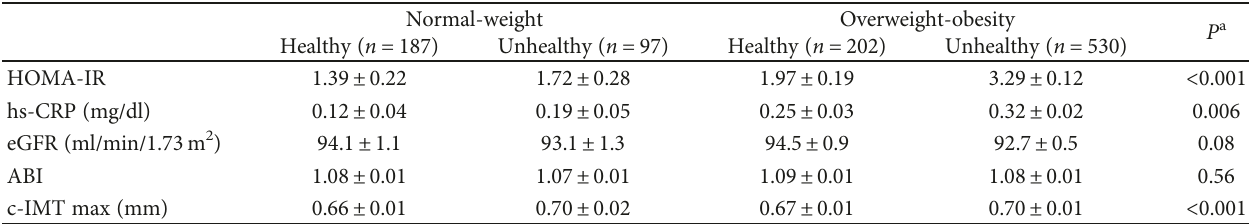
Table 5: Estimated means of the dependent variables corrected for the covariates age, gender, and physical